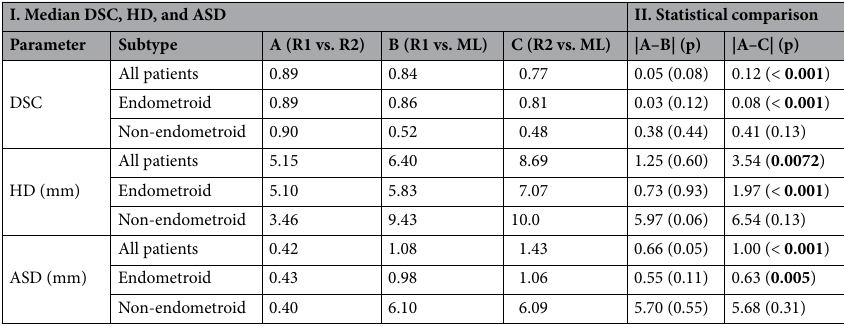
Table 1. Differences in DSC, HD, and ASD between human raters (R1, R2) and machine learning (ML) in the test cohort. Performance is reported for all patients and separately for endometroid ( n = 30 ) and non- endometroid ( n = 5 ) subtypes. I : Median value of agreements A = rater 1 with rater 2 (inter-rater agreement), B = rater 1 with ML, C = rater 2 with ML of DSC, HD, and ASD. II : Absolute difference in median value (p-values in brackets) of the comparisons A with B and A with C, corresponding to inter-human agreement compared to human with ML. Significant differences are marked with bold. For all patients there was no difference in inter-rater agreement compared with ML against rater 1 for DSC, HD, or ASD (A–B: p = 0.08, p = 0.60, and p = 0.05, respectively) whereas lower agreement was observed between rater 2 and ML compared to inter-rater agreement for DSC, HD, and ASD (A–C p ≤ 0.0072 for all). Similar differences between ML and rater 2 compared to inter-rater agreement were found for the endometroid subtype (p ≤ 0.01), but not for rater 1. No statistical differences in performance were detected for non-endometroid subtype although the difference in estimates |A–B| and |A–C| of DSC and ASD were higher for non-endometroid subtype than for endometroid